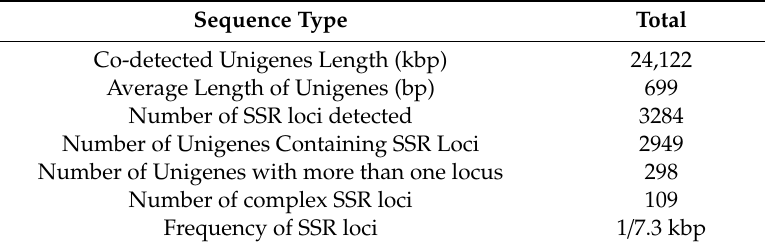
Table 1. Character of Unigenes in L. formosana.